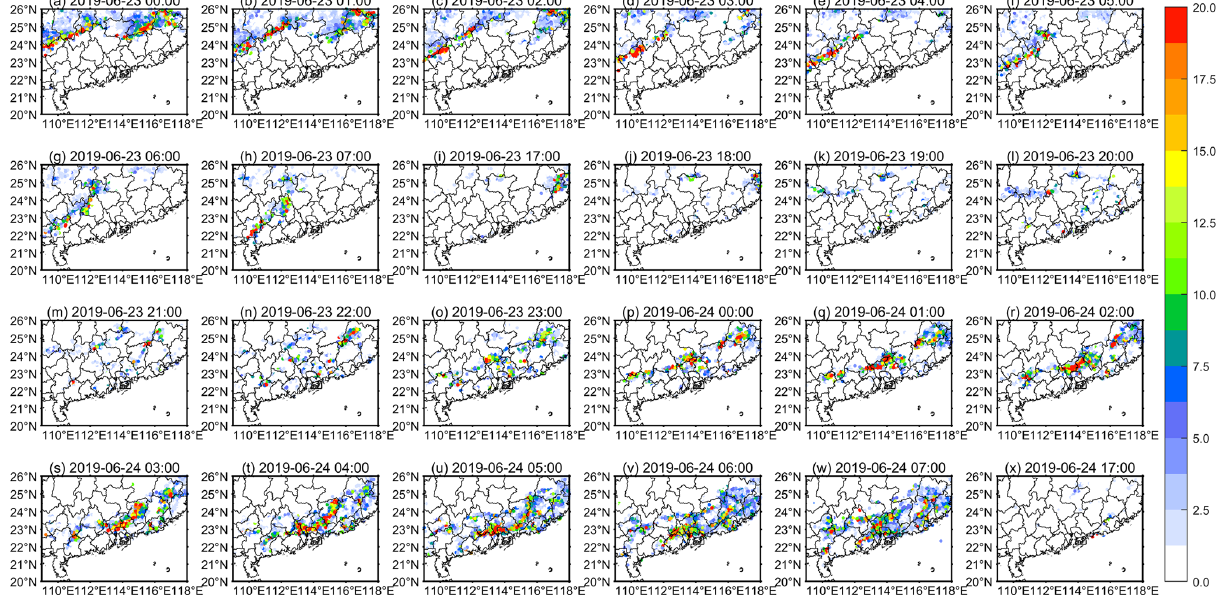
Figure 8. Actual precipitation based on high-density automatic stations at (a–h) 00:00–07:00CST on 23 June, (i–o) 17:00–23:00CST on 23 June, (p–w) 00:00-07:00CST on 24 June and (x) 17:00CST on 24